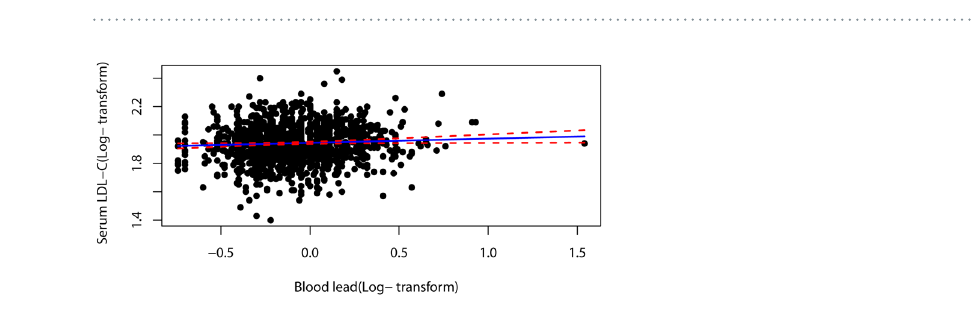
Figure 2. Estimated percent difference (% diff) and 95% Confidence Intervals (95% CI) in serum LDL-C concentrations in U.S. adolescents 1999–2012 for each interquartile ratio (IQ Ratio) increase in blood lead levels.